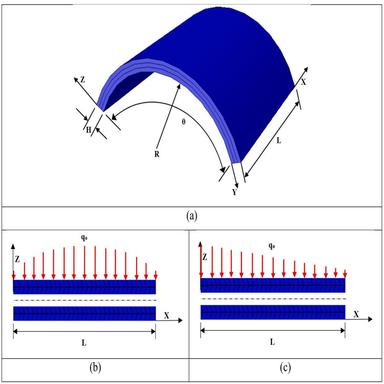
(a) GFRP panel (b) Sinusoidal distributed load (SSL) (c) Uniformly varying load (UVL).